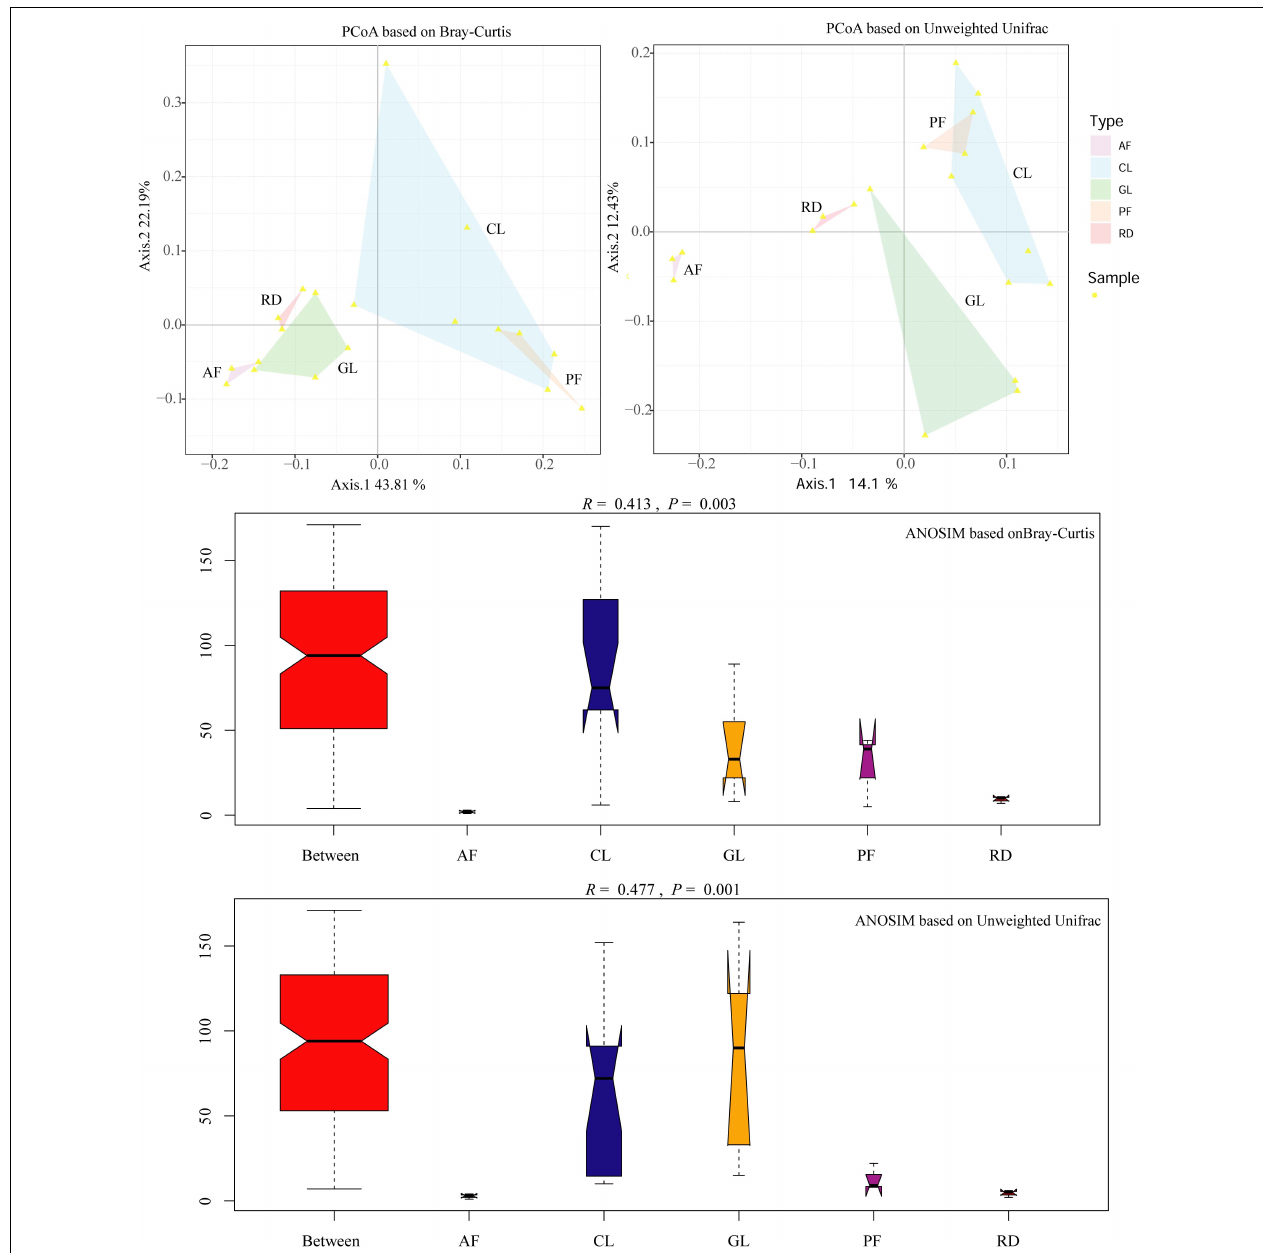
FIGURE 3 | PCoA plots and ANOSIM analysis based on unweighted Unifrac and Bray-Curtis distances representing the soil bacterial community similarity/dissimilarity. Ordinate–the rank of the distance between samples; Abscissa–Between is the result between the five ecological types, and the other five are the results within their groups,